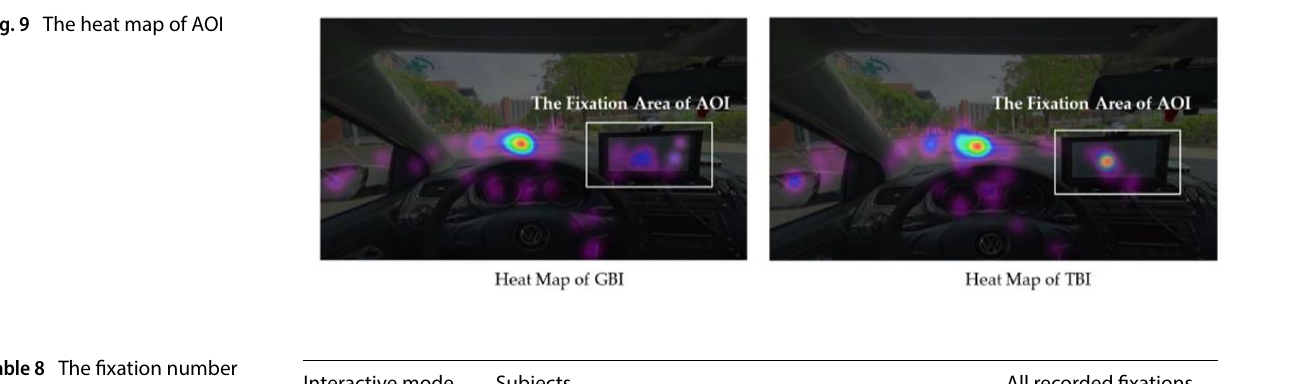
Fig. 9 The heat map of AOI